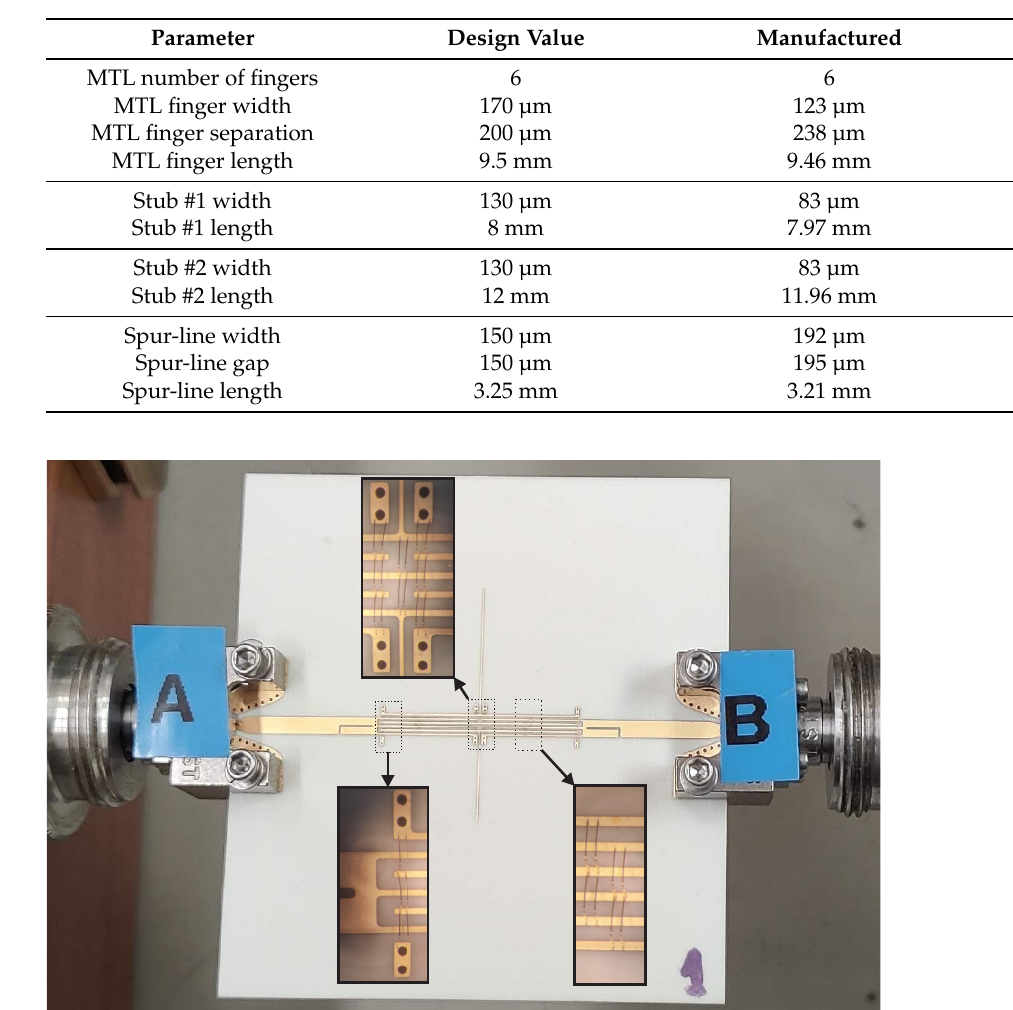
Figure 4. Photograph of the manufactured prototype with 6-finger short-circuited MTLs and two shunt open stubs. Detail of the wire-bondings used to guarantee equal potential at the ends and in the middle of the structure are detailed in